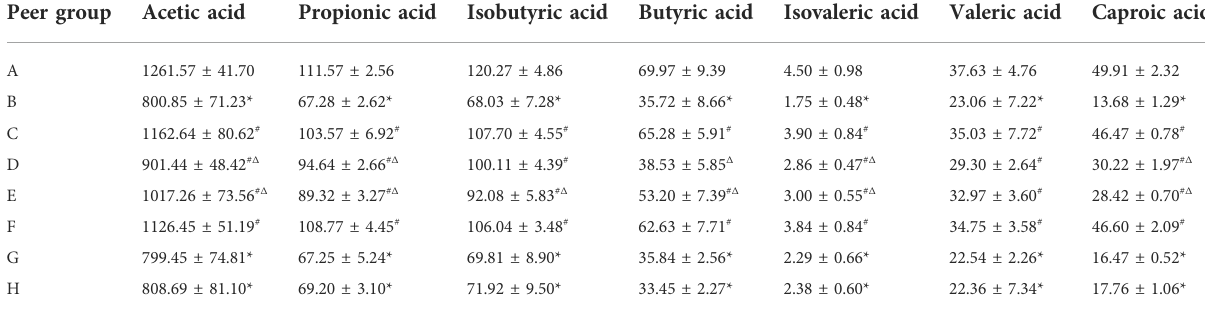
TABLE 2 Intestinal SCFAs content of rats in each group ( n = 6, (cid:1) x ± s , μ g/g). Peer